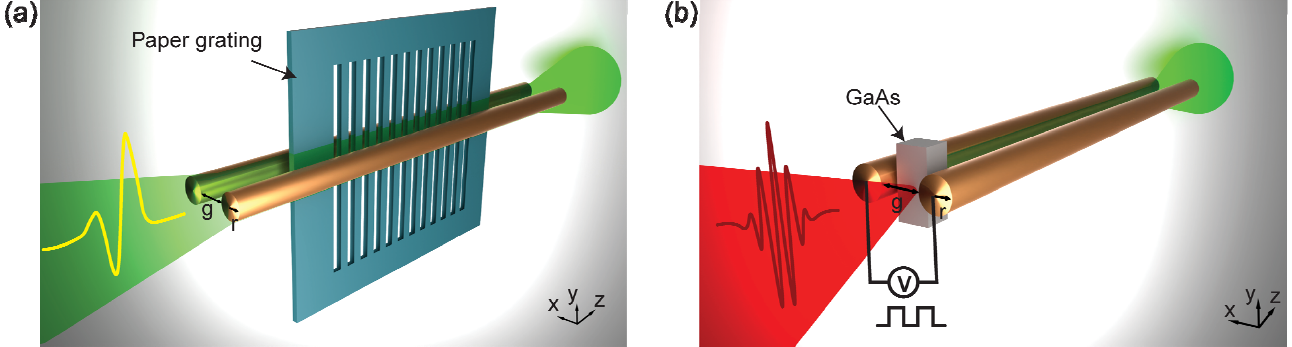
Figure 2. THz metal-wire signal processors realized by inserting standalone components. ( a ) Sche- matic of a THz waveguide Bragg grating (adapted from [38]), which was fabricated by using a TWWG with a wire radius r = 125 µm, an air gap g = 900 µm, and a paper grating with a thickness